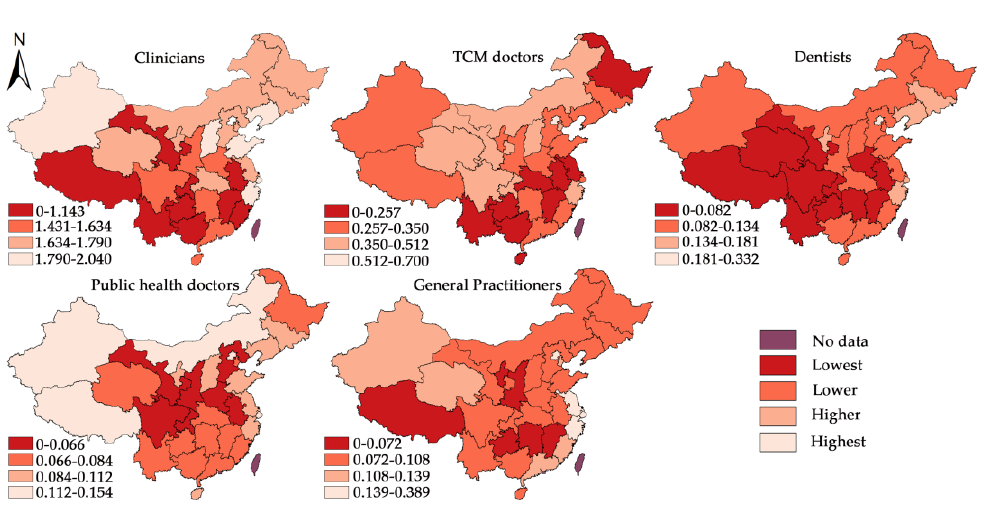
ff erent subtypes of licensed doctors during Figure 3. Average densities of different subtypes of licensed doctors during 2012 – 2016. Figure 3. Average densities of di